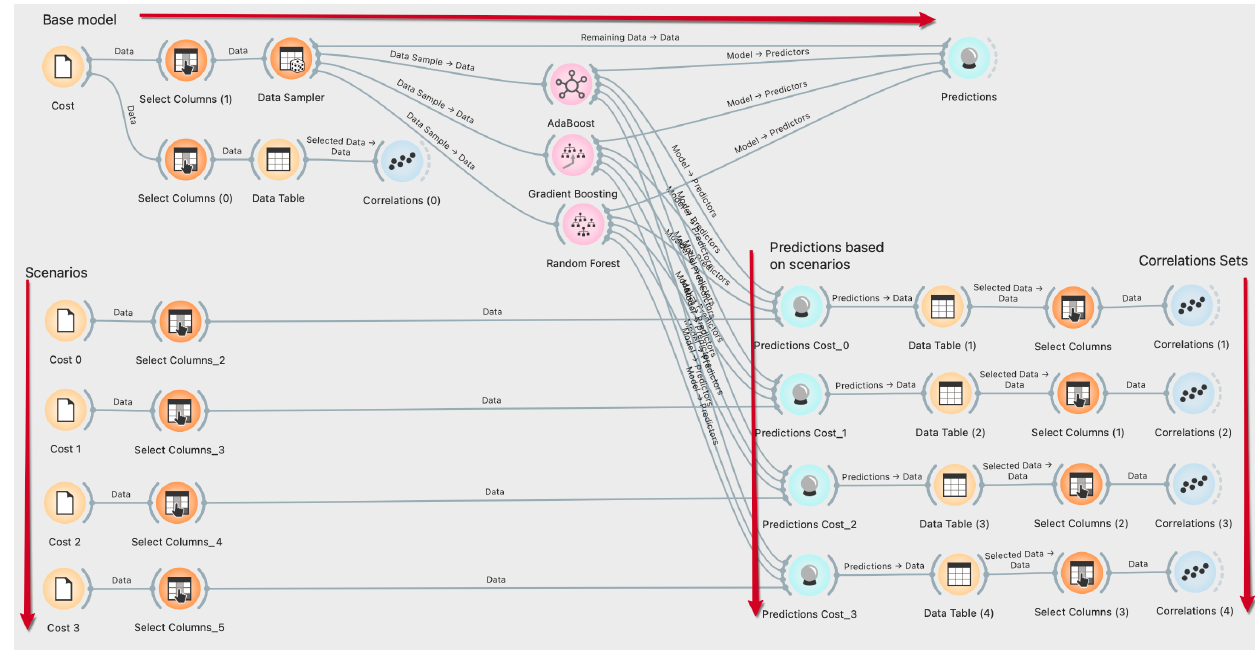
Figure 4. The flowchart of the ML algorithms of the study.